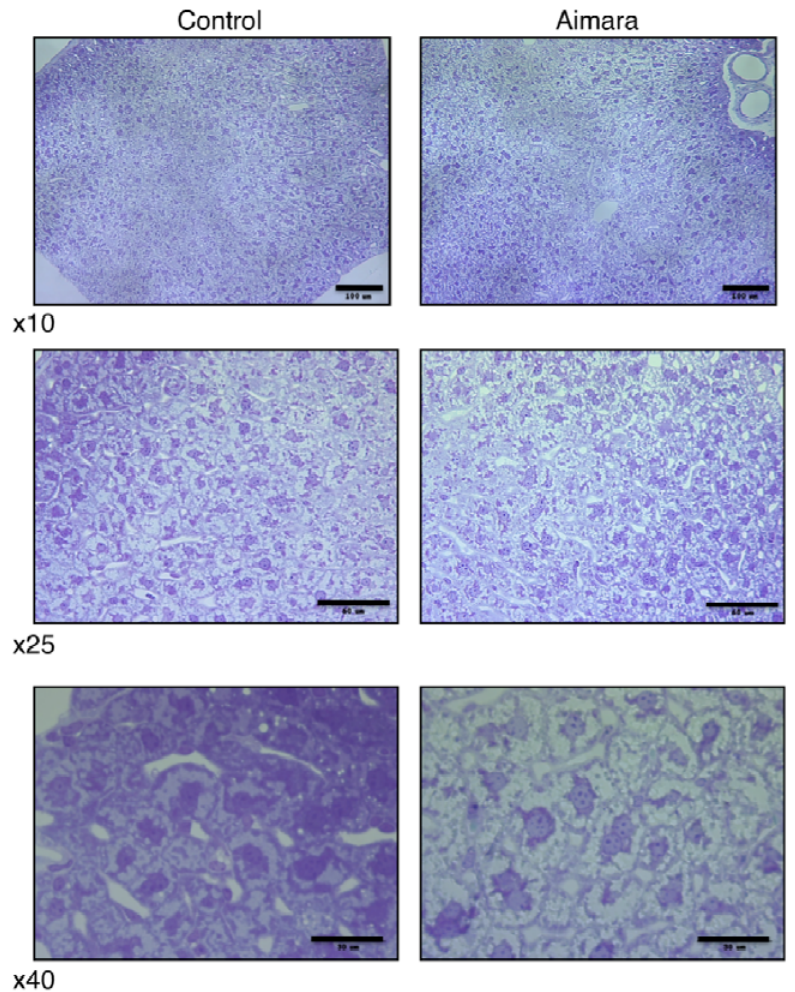
Figure 1. Optical microscopy of the liver in wild-type mice after 7 months of exposure to an aimara-containing diet. Scale bars are equal to 100, 60 and 30 µm from top to bottom and correspond to 10×, 25×, and 40× magnifications,